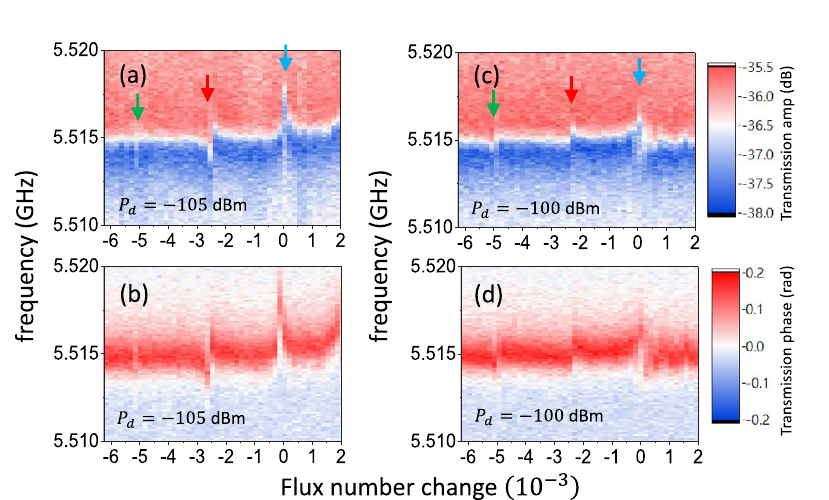
Figure 4. Avoided-crossing of dressed states. Transmission amplitude ( a ) and phase ( b ) as a function of flux 105 dBm. Transmission amplitude ( c ) and phase ( d ) as a function of flux number number change at P d = − 100 dBm. The blue, red and green arrows respectively indicate the resonance for m change at P d = − 3 sidebands with the probe